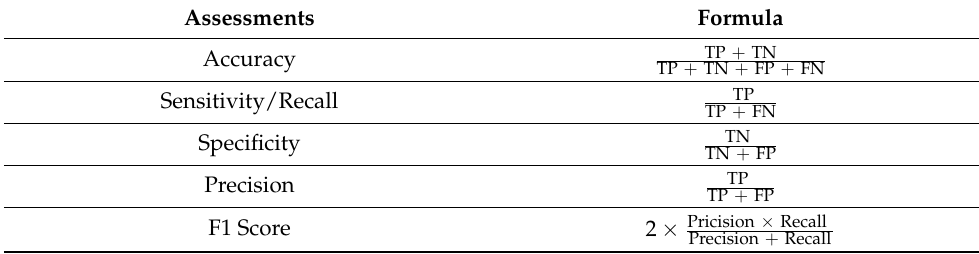
Table 5. Performance Evaluation Metric.